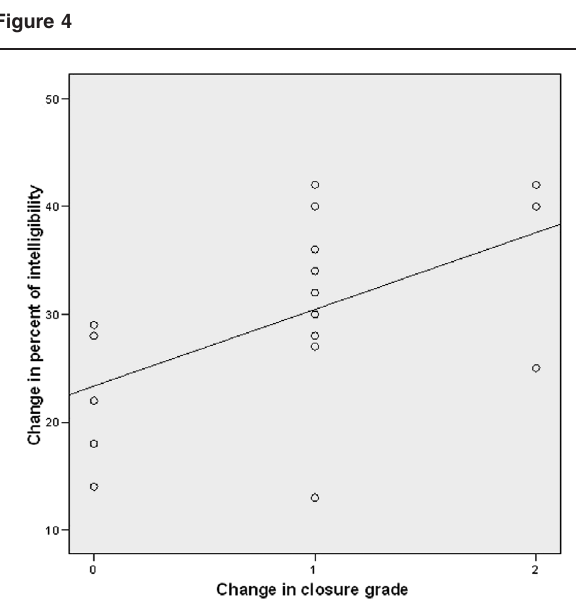
Correlations between change in grade and change in percent of intelligibility after operation.